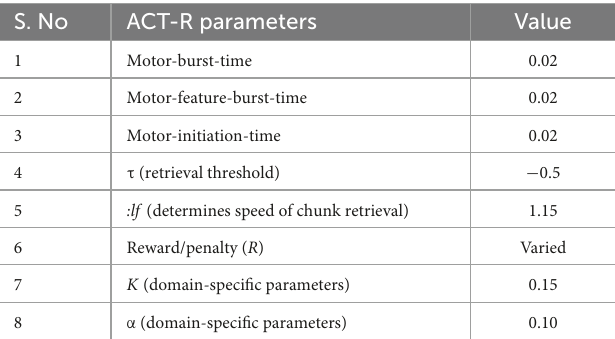
TABLE 1 ACT-R parameters tuned for HDT of process